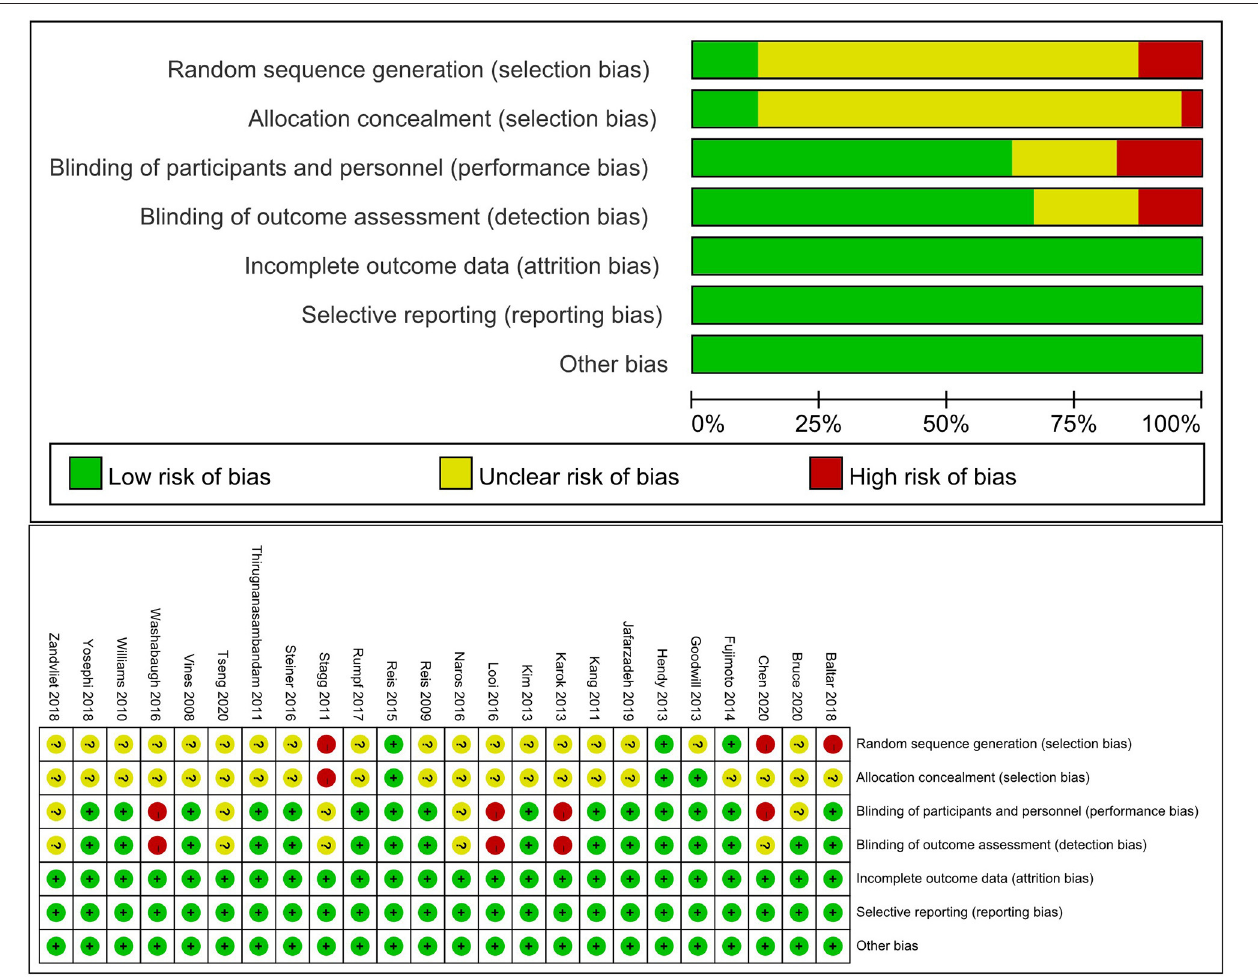
FIGURE 2 | Risk of bias